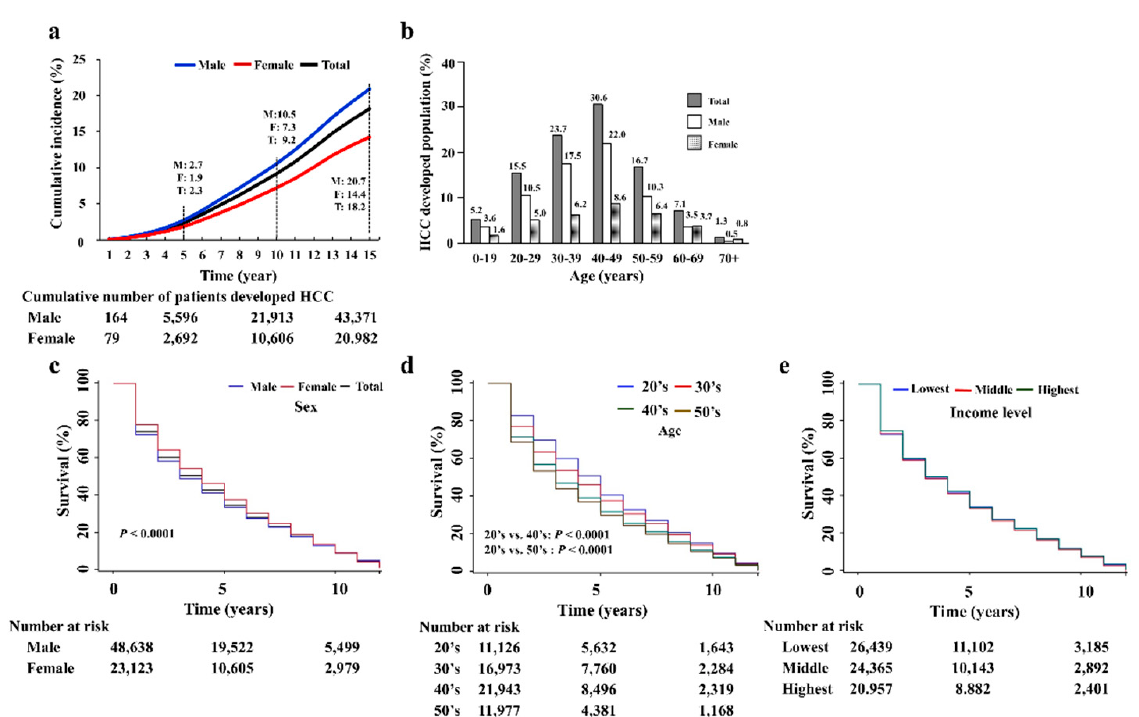
Figure 4. Cumulative incidence rate and survival rates of patients who newly developed HCC during LTC. ( a ) Cumulative incidence of HCC development according to sex. ( b ) The distribution of age group who developed HCC during LTC. ( c ) Kaplan-Meier plots for survival estimates after HCC development by sex. ( d ) Kaplan-Meier plots for survival estimates after HCC development by age. All the p -values were less than 0.0001 in the comparison between 20’s vs. 30’s, 20’s vs. 40’s, 20’s vs. 50s, 30’s vs. 40’s, 30’s vs. 50’s, and 40’s vs. 50’s. ( e ) Kaplan-Meier plots for survival estimates after HCC development by income levels.